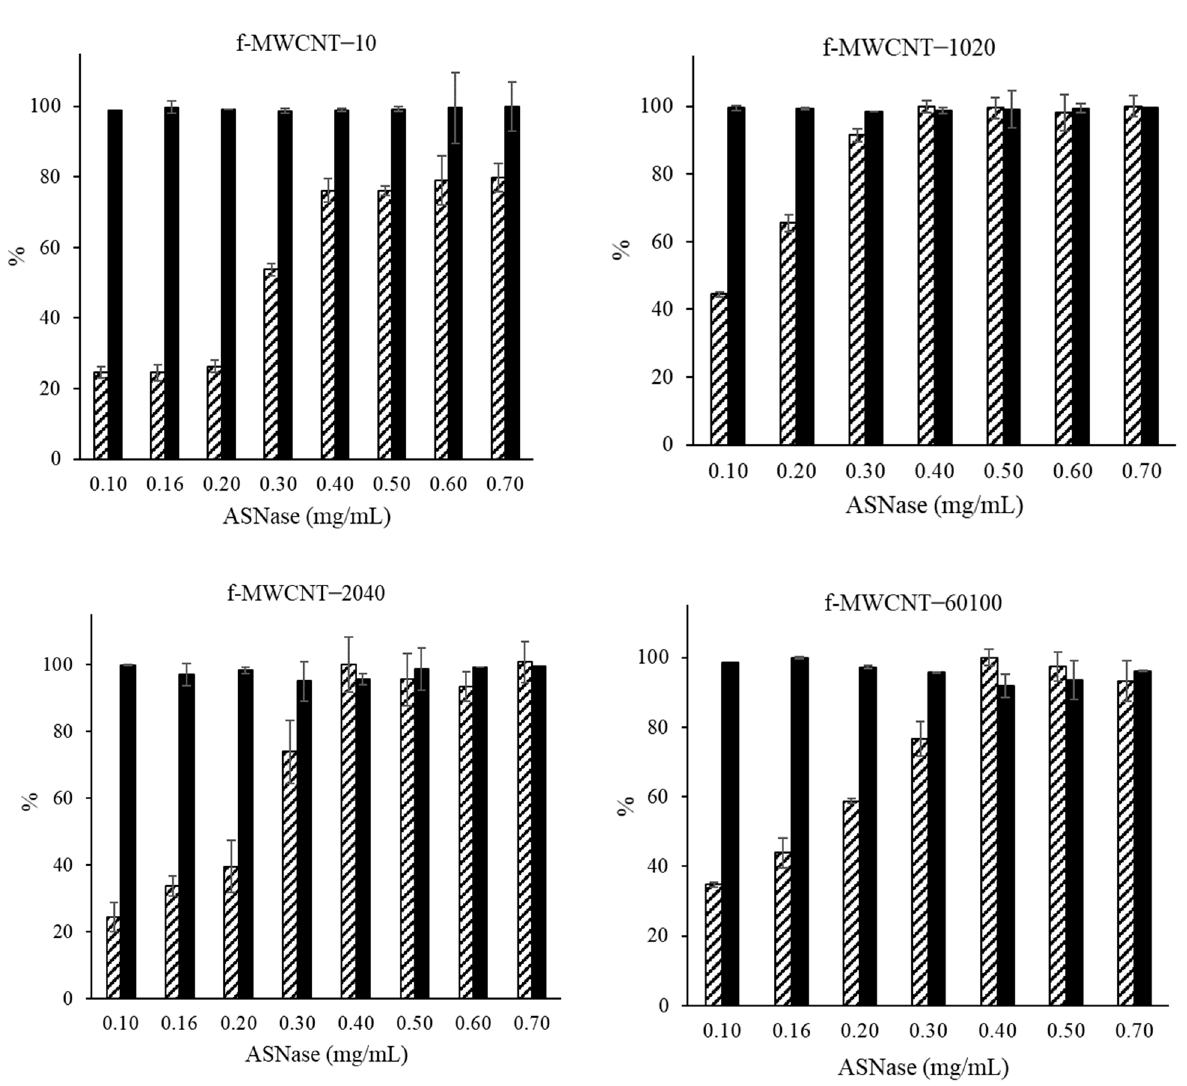
Figure 5. Effect of L-asparaginase (ASNase) concentration on the immobilization yield ( IY) ( ■ ) and relative recovered activity ( RRA) ( ) . ASNase immobilization onto 2 mg of functionalized multi-walled carbon nanotubes (f-MWCNTs) at pH 8.0 for 30 min. Error bars correspond to the standard deviation between replicates.